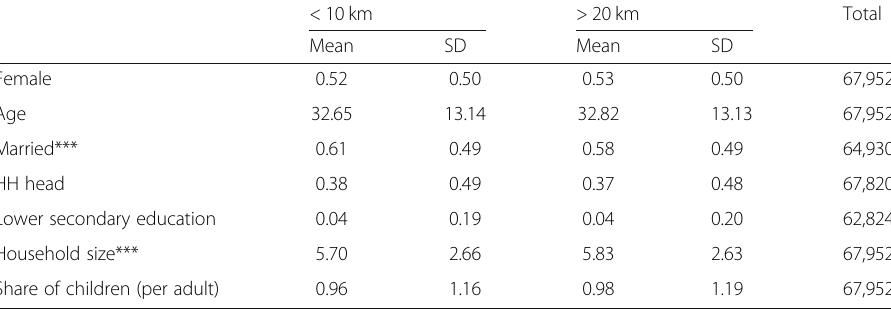
Table 5 Descriptive statistics of covariates (for working age individuals) using ‘ 91